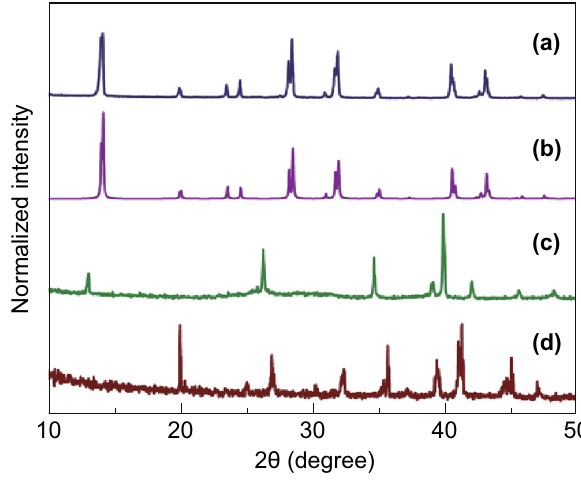
Fig. 12 XRD patterns of as-prepared material: (a) simulated MAPbI 3 , (b) as-ground MAPbI 3 , (c) PbI 2 , (d) MAI. Reproduced with permission Ref. [29]. Copyright (cid:2) 2015 The Royal Society